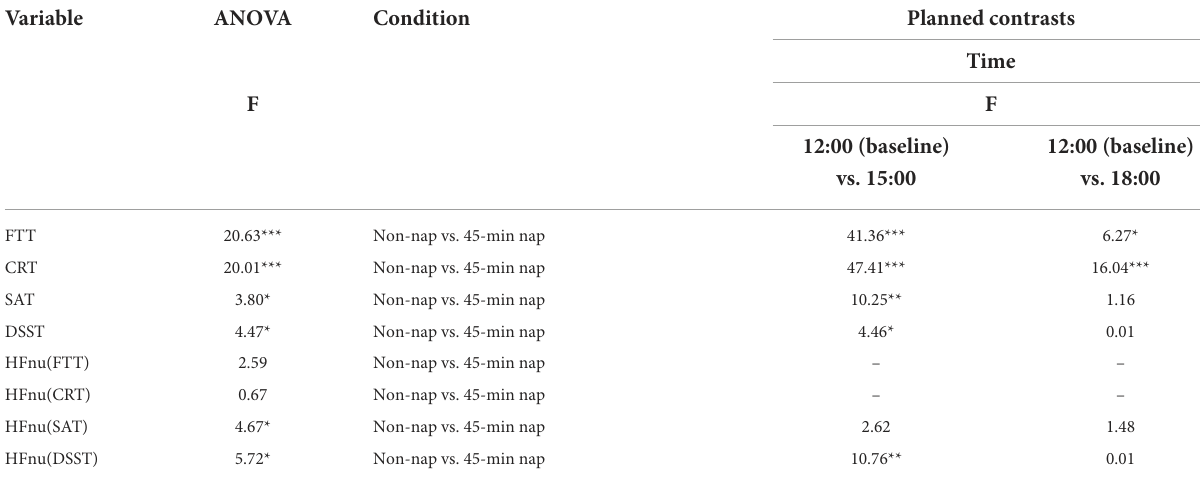
TABLE 4 Two-way ANOVA and planned within-subjects contrasts for time (pre-nap vs. post-nap time) by condition (non-nap vs. 45-min nap) for the dependent variables. Variable